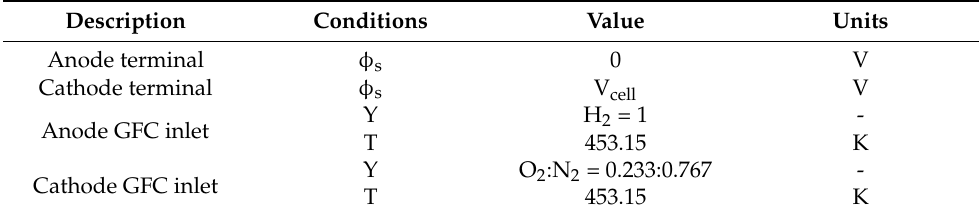
Table 4. Parameters used in the mathematical